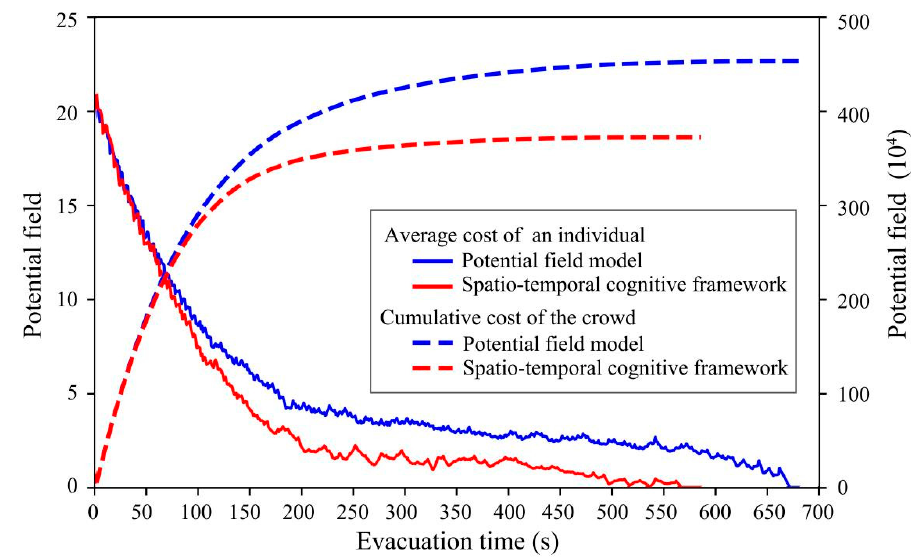
Figure 8. The cumulative count of the crowd not evacuated and the proportion of the crowd not evacuated with two route choice models.